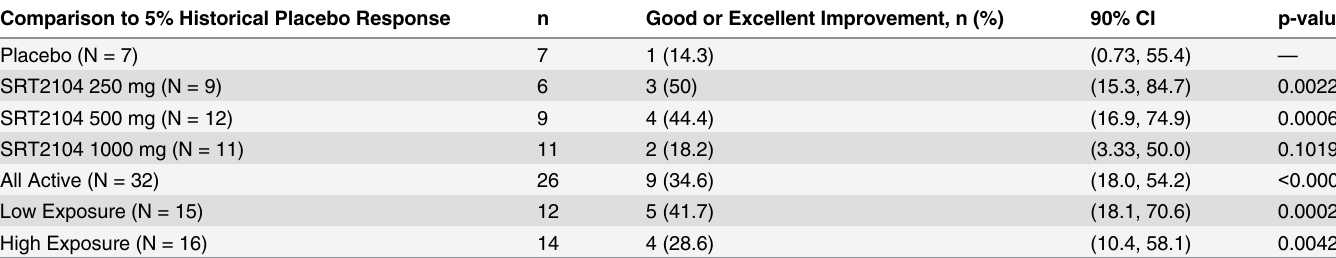
Table 2. Proportion of Subjects with Good-Excellent Histological Improvement vs. Historical 5% Placebo rate – Day 84.